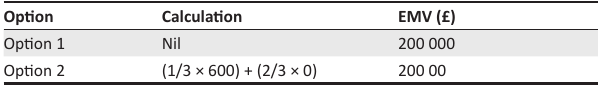
TABLE 2: EMV for Initiative A, when options are in terms of gains.